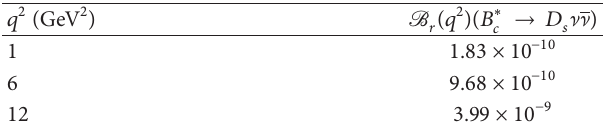
Table 3: Values for the branching ratio of the 𝐵 ∗ 𝑐 → 𝐷 𝑠 ]] decay at three different values of the dileptonic invariant